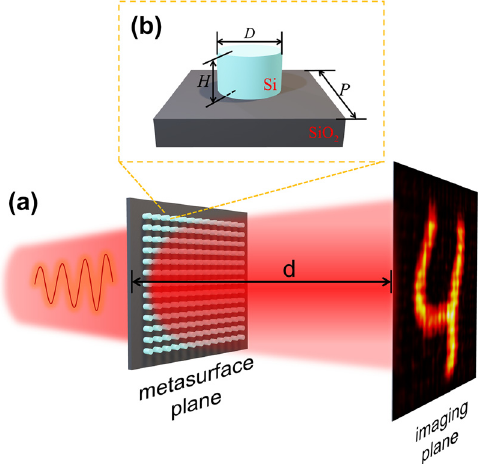
Figure2: Aschematicviewofthemetasurface-basedhologram.The coherentplanewavepassesthroughthedesignedmetasurface,and a target holographic image is displayed at the imaging plane after a diffractionpropagationdistance d .Insetshowsthediameter( D )and height ( H ) of the Si-cylinder cell, which serve as the designed pa- rameters in the section of Methods, and P denotes the period of nanocylinder